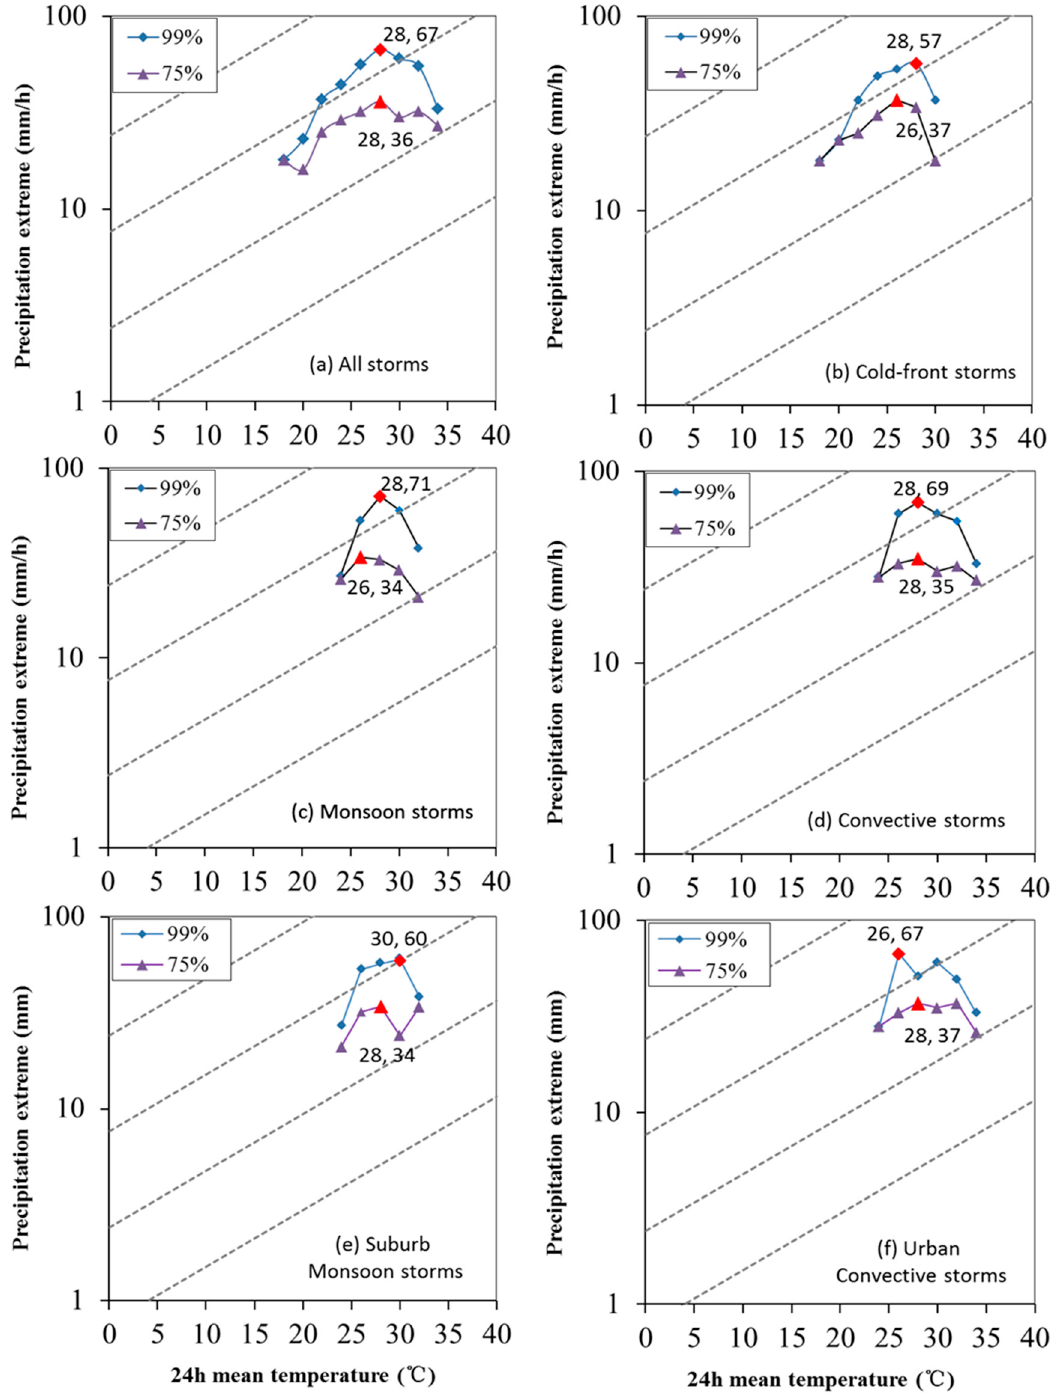
Figure 10. The scaling rates between the 24-h mean air temperature prior to the storms and the hourly precipitation extremes at the 75th and 99th percentile for ( a ) all of the storms from April to September, ( b ) cold-front storms from April to mid-May, ( c ) monsoon storms from mid-May to June, ( d ) the convective storms from July to September, ( e ) monsoon storms at the suburb stations, and ( f ) convective storms at the urban stations. The marked values on each plot are the break temperature and precipitation extremes. The gray dashed lines are the standard Clausius–Clapeyron (CC) scaling rate. The Y-axis scale is in